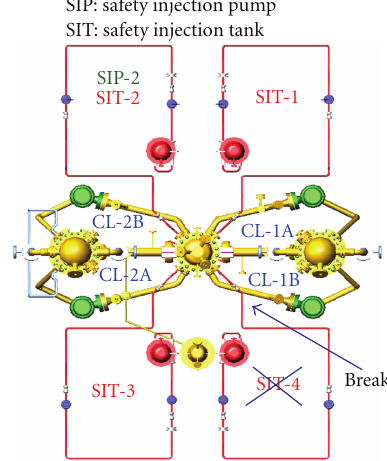
Figure 8: A loop arrangement for a DVI line break with a single failure assumption.